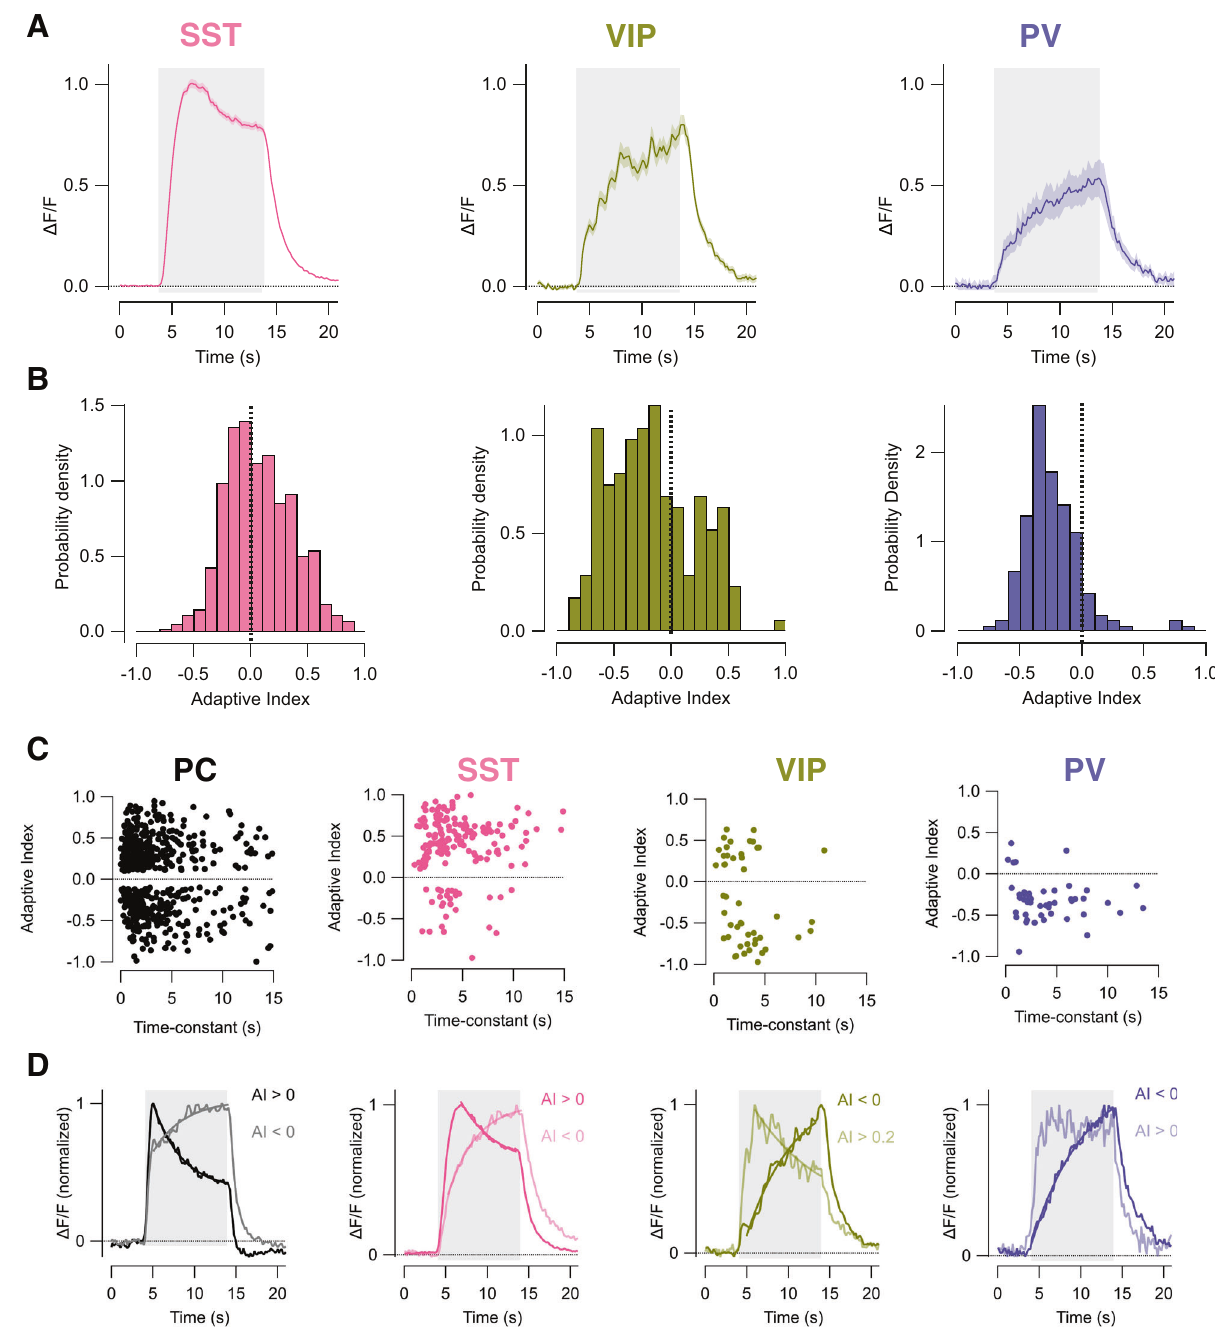
Fig. 3 Adaptation in different classes of interneuron. A Average population response to the high-contrast stimulus in SST (left; four mice, 537 cells), VIP (middle, three mice, 175 cells) and PV interneurons (right, two mice, 162 cells). The timing of the stimulus is shown by the grey bar. B Distribution of AI measured within each interneuron type shown in A . Note the strongly sensitizing responses in PV and VIP interneurons. SST cells were predominantly depressing but some were sensitizing. C Scatter plots showing the AI of a neuron in relation to its time-constant of adaptation. From left: pyramidal cells (PC, n = 580), SST ( n = 167), VIP ( n = 48), and PV ( n = 49) classes. The average time-constants for AIs > 0.1 were: 3.7 ± 3.4 s (PC, mean ± sd), 4.0 ± 3.1 s (SST), 2.8 ± 2.9 s (VIP), and 1.9 ± 2.7 s (PV). The average time-constants for AIs < − 0.1 were: 3.1 ± 3.1 s (PC), 4.3 ± 2.3 s (SST), 3.5 ± 2.5 (VIP), and 4.3 ± 2.3 s (PV). The time-constant was only estimated if the major part of the response to the stimulus could be better described as a single exponential compared to a line and only if AI > 0.1 or AI < − 0.1. D Estimates of the average time-constant of adaptation across populations of neurons were obtained by fi tting exponential functions (smooth lines) to the average of their normalized responses. PC: AI > 0, 3.4 ± 0.2 s; AI < 0, 3.7 0.7 s. SST: AI > 0, 4.2 ± 0.4 s; AI < 0, 3.5 ± 0.3 s. PV: AI < 0, 6.4 ± 0.4 s. VIP: AI < 0, 7.5 ± 1.3 s; AI > 0.2, 8.5 ± 4.7 s. Note the similar time-constants of adapting and sensitizing adaptation in PC and SST (~3 – 4 s). In interneurons where sensitizing adaptation was dominant (VIP and PV), the time-constant was longer (~6 – 8 s). Data are represented as mean ± SEM (coloured shading area in ( A ). Source data are provided as a Source Data fi